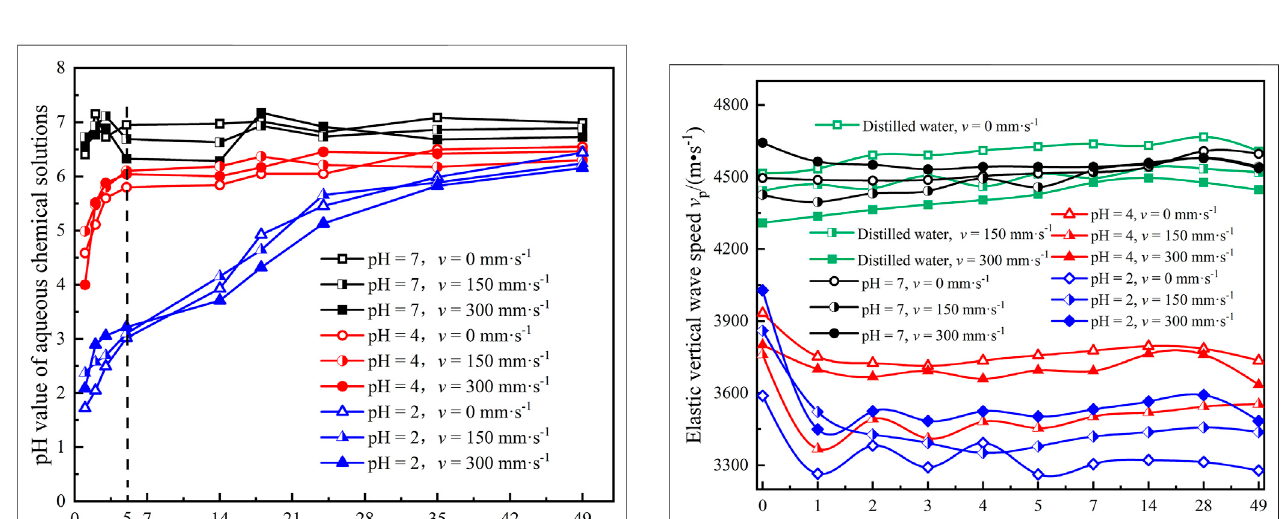
Frontiers in Earth Science | www.frontiersin.org July 2022 | Volume 10 | Article 927159